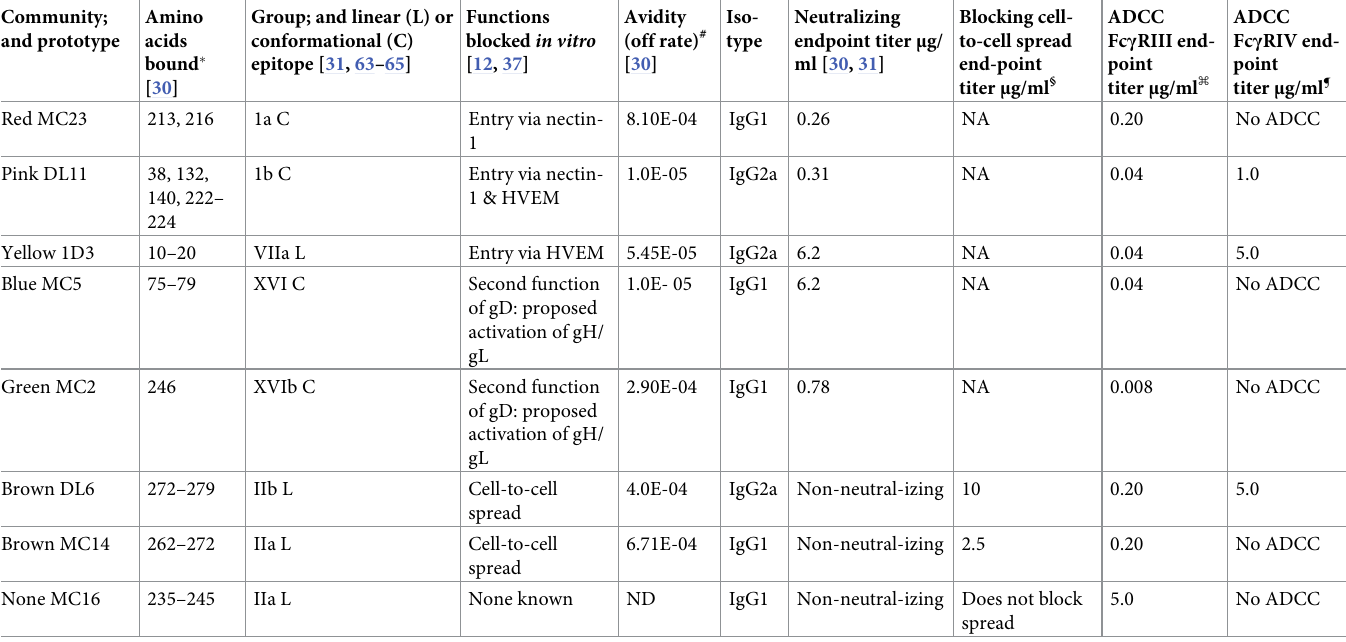
Fig 4. Blocking cell-to-cell spread and binding to murine Fc γ RIIIand Fc γ RIV receptors by prototype MAbs. (A) MAbs MC16, DL6 and MC14 were added to HSV-2-infected HaCaT cells and plaque size was measured after 48 hours. R265 represents anti-gE2 polyclonal rabbit IgG used as a positive control. The dotted line represents plaque size in wells that contained media with no added antibodies. P values were determined by comparing plaque size in wells with added antibodies with the no-added antibody control wells. Statistics were calculated by Mann-Whitney; (cid:3) p < 0.05; (cid:3)(cid:3)(cid:3)(cid:3) p < 0.0001; ns, not significant. (B-C) Binding of MAbs to murine IgG Fc γ RIV or Fc γ RIII that mediate ADCC. Endpoint titers were calculated based on the lowest MAb dilution that produced luminescence readings 2-fold higher than the no antibody control. Note that the Y-axis scales are different for B and C. https://doi.org/10.1371/journal.ppat.1007095.g004 These two animals had significantly more lesion days than the 23 animals that produced anti- bodies to that epitope. The lack of response to no other crucial epitope was significantly associ- ated with more lesion days, although animals that failed to produce antibodies that blocked the brown MC14 and red MC23 epitopes had more lesion days that approached statistical signifi- cance (Table 2). These results suggest that antibodies to the receptor binding epitopes, repre-